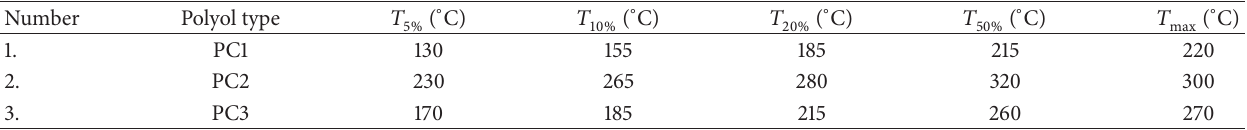
Table 2: Thermal stability of hydroxypropyl derivatives of